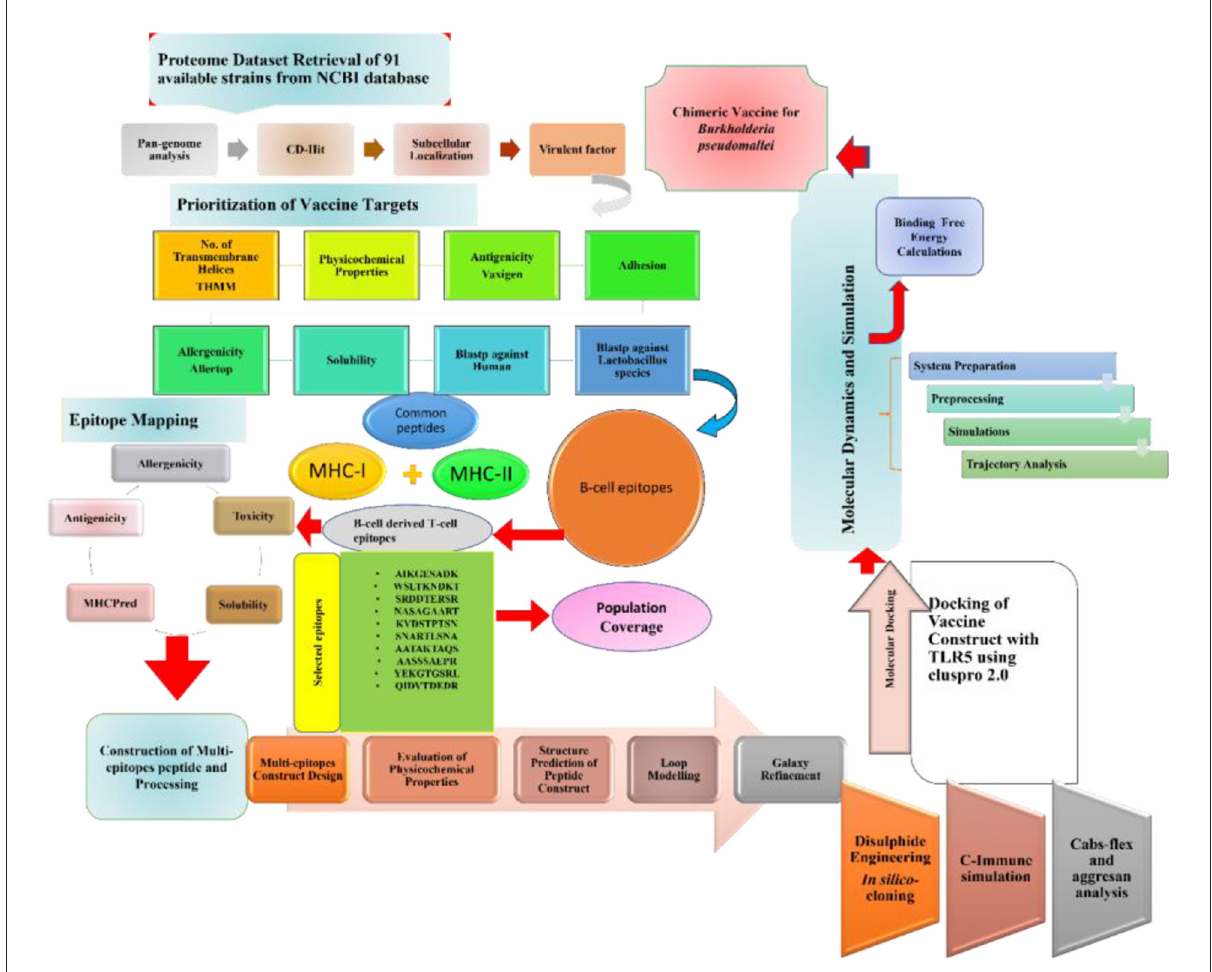
FIGURE1 Schematic diagram of the methodology and steps followed in this